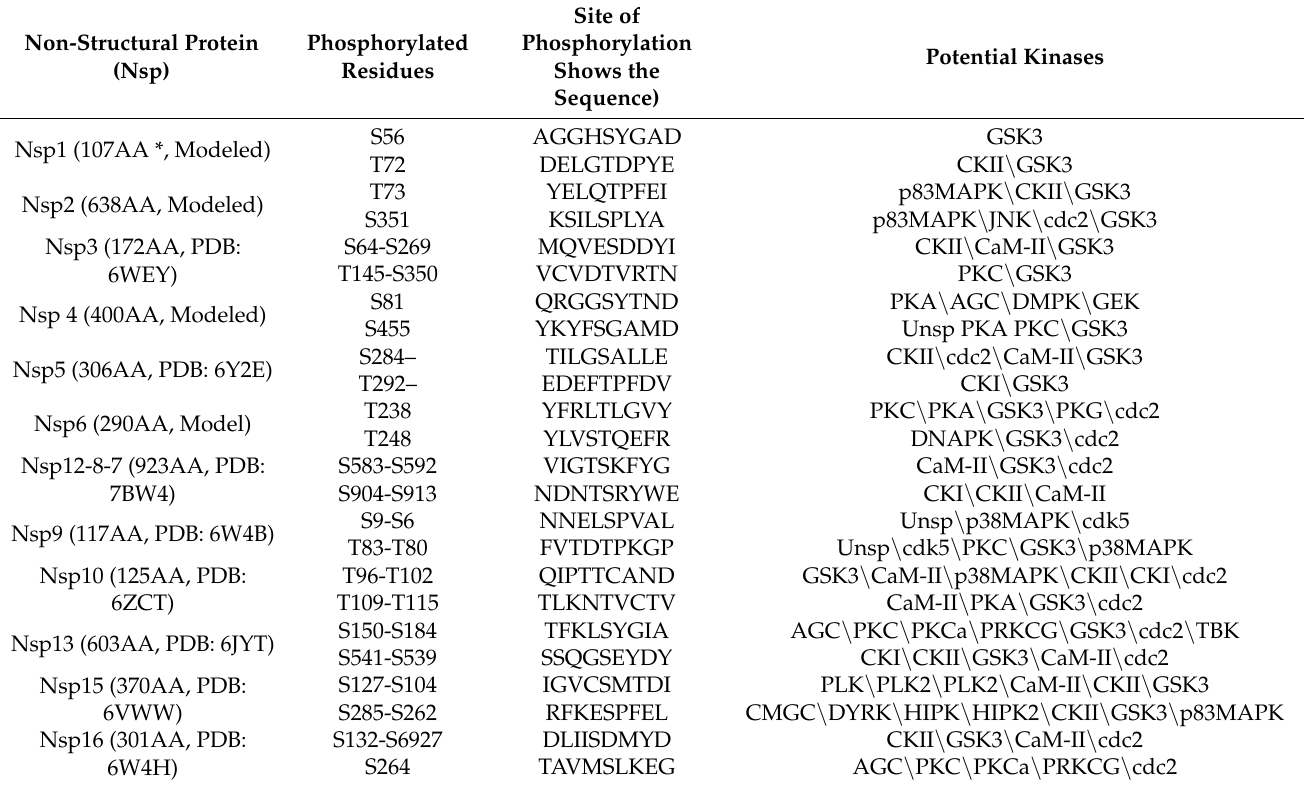
Table 2. List of selected protein and phosphorylation sites and